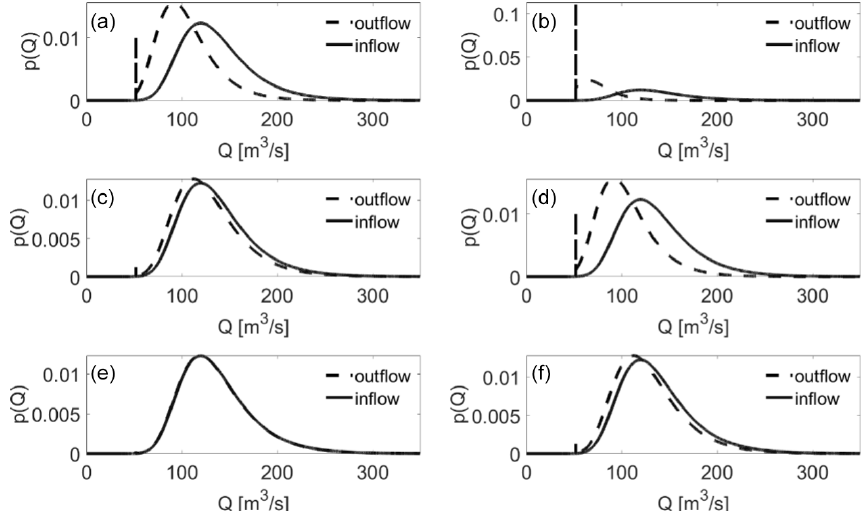
Figure 4. Derived probability density functions of the outflow associated with different equivalent event durations, t p , using two different coefficients of the stage-storage capacity curve, w 1 , which was set equal to 5000 in (a) , (c) , and (e) , while it assumes values of 10000m 3 in (b) , (d) , and (f) . Event duration changes between 0.5 (a, b) , 1 (c, d) , and 2h (e, f) . Other parameters are α = 30m 3 /s; β = 120m 3 /s; b = 4m; d = 2m; n = 1 . 5; h f = l f + d/ 2; h s = 4; µ f = 0 . 85; µ s = 0 . 385; L =